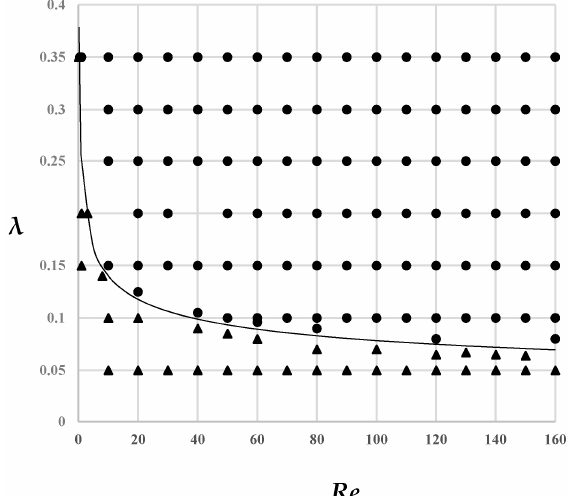
Figure 4. Inertial focal points on the parameter plane of Re and λ , ● for focusing points and ▲ for unfocusing ones.